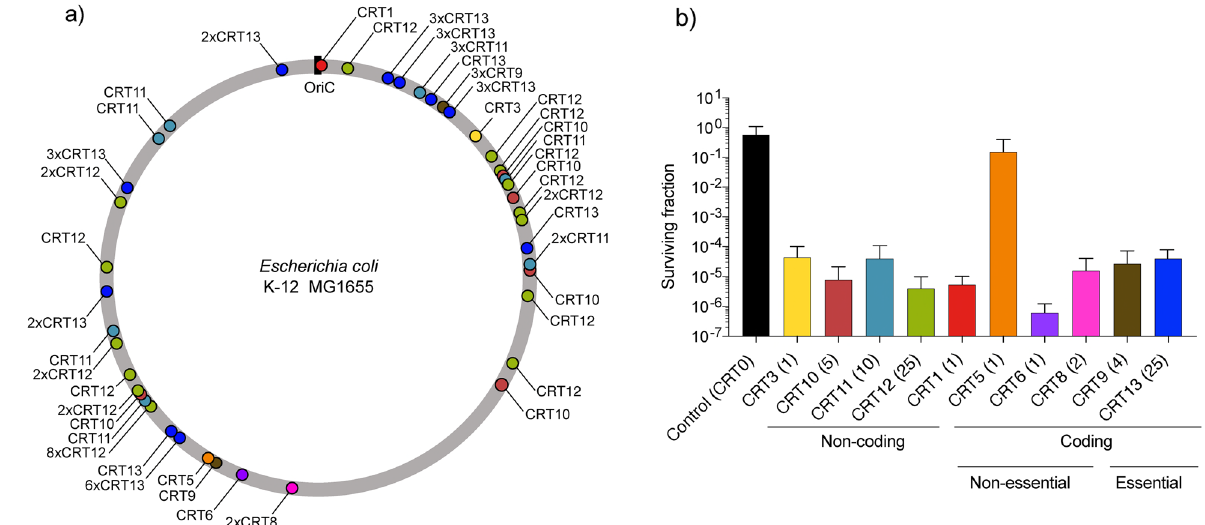
Figure 1. gRNA targets in the chromosome of E. coli K-12 MG1655. ( a ) Chromosomal map of E. coli K-12 MG1655 indicating the oriC and the cutting sites of the different CRISPR targets (CRTs). ( b ) Efficiency of the CRTs determined by the surviving fraction, the CRTs are ordered by gRNAs targeting non-coding vs. coding regions, non-essential vs. essential genes and the number of cutting sites. CRT0 indicated as a black bar served as a control gRNA with a non-targeting